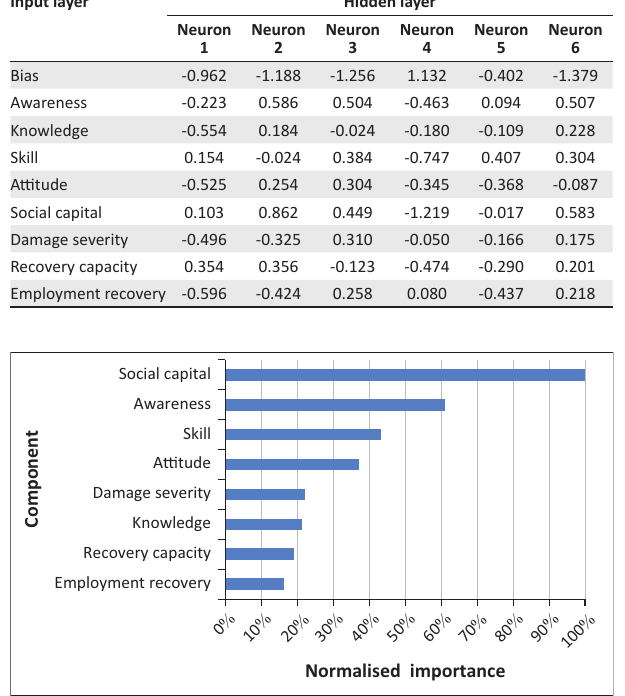
FIGURE 4: The importance of each independent variable in the neural network